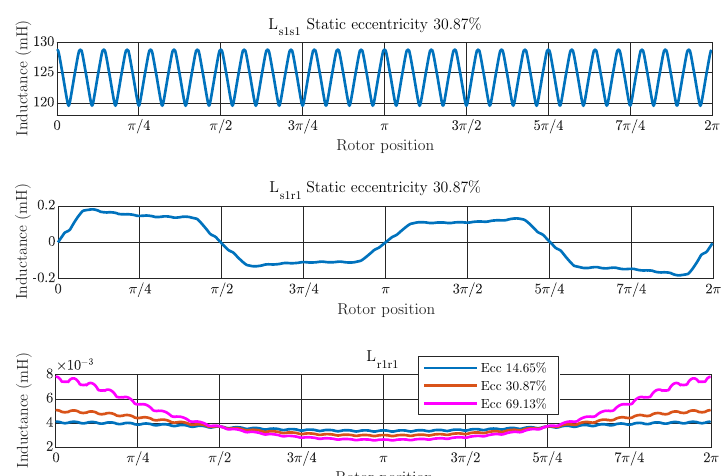
Figure 3. Coupling parameters between stator phase 1 and itself ( top ), between stator phase 1 and rotor bar 1 ( middle ) and between rotor bar 1 and itself ( bottom ) for static eccentricity of 30.87% depending of the rotor position using FEM simulations. The bottom graph also shows the coupling parameters between rotor bar 1 and itself for static eccentricity of 14.65% and 69.13%. Table 2. Set of points in the parametric space [ 0, π /14 ] to compute [ L ss ] and [ L sr ] . Point Rotor Position θ